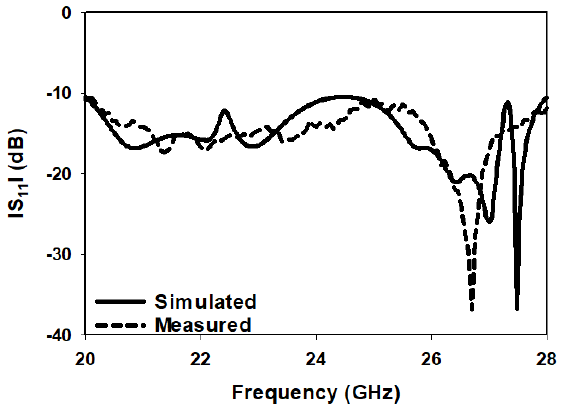
Figure 8. The S 11 of an array of two hemispherical DRAs with outlined antenna positions on the ground plane.